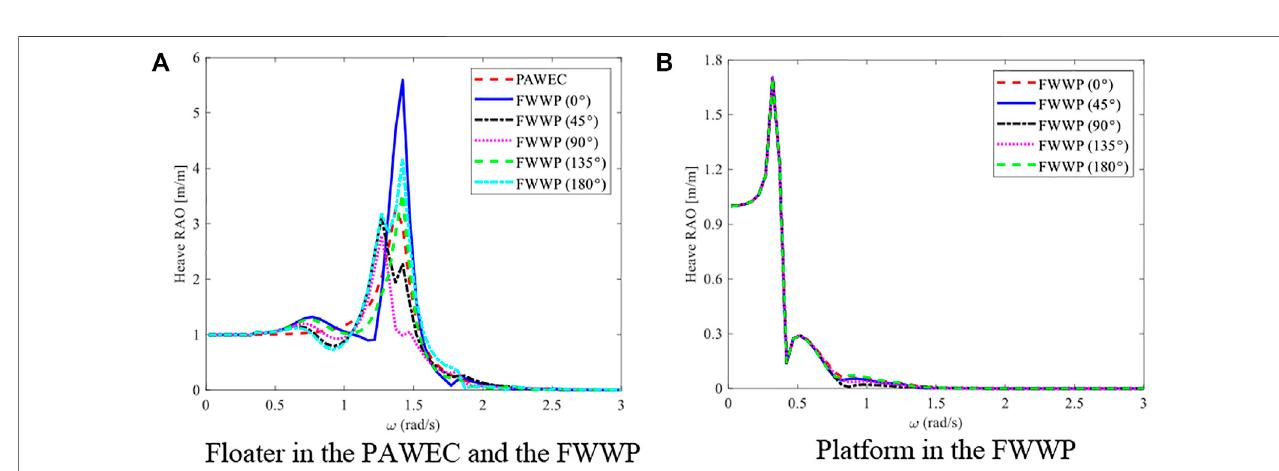
FIGURE 5 | Heave motion RAO comparisons. (A) Floater in the PAWEC and the FWWP. (B) Platform in the FWWP.